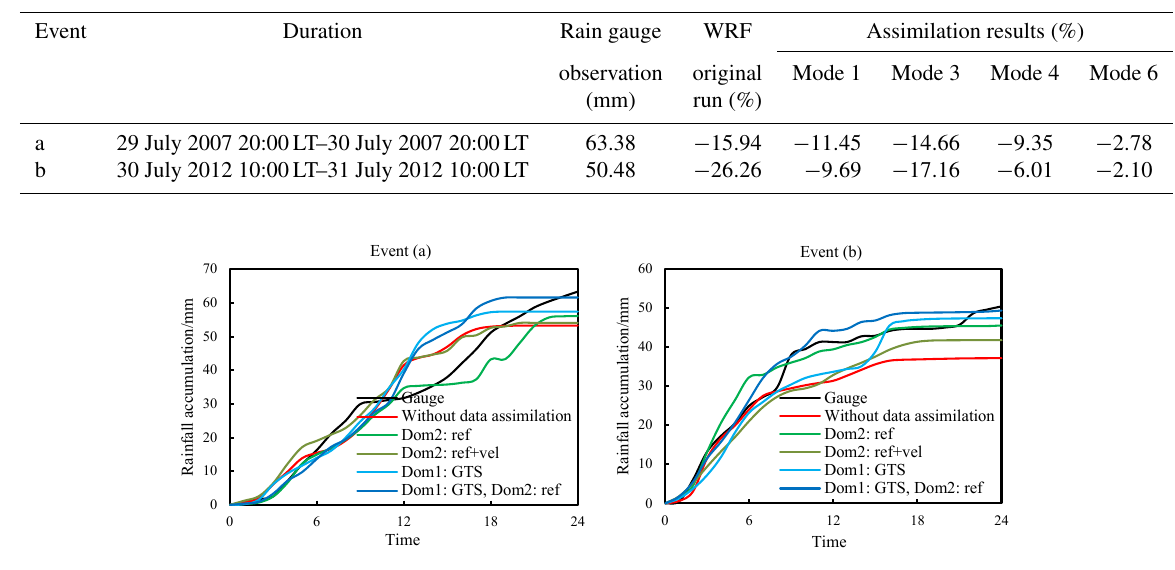
Figure 9. Cumulative hyetographs of the two storm events in the analogue catchments with different data assimilation